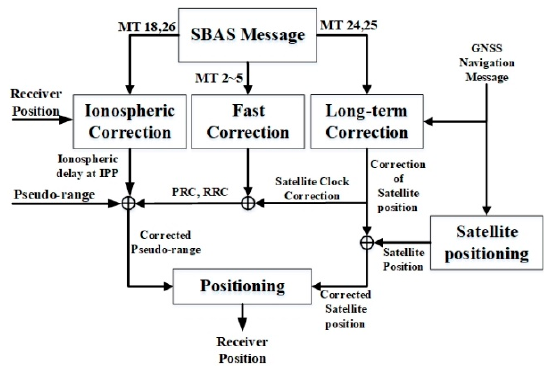
Figure 1. Positioning procedure using satellite-based augmentation system (SBAS) corrections.